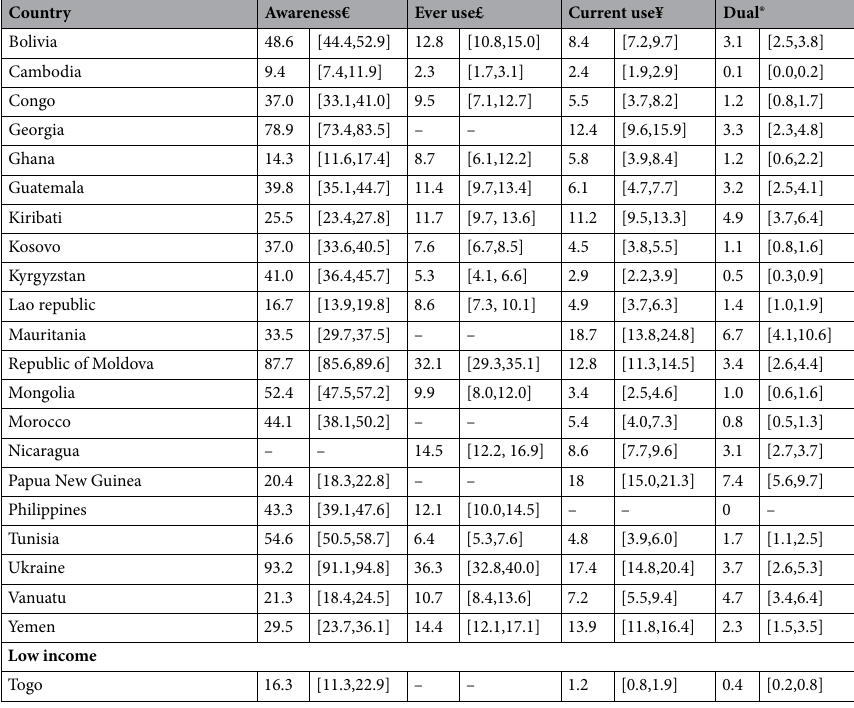
Table 1. Country-wise overall estimates (%) and their 95% CI of awareness about e-cigarettes, ever and current use of e-cigarettes and dual use for the data available in 75 GYTS countries. € -69 countries, £- 54 countries, ¥- 67 countries, ®-67